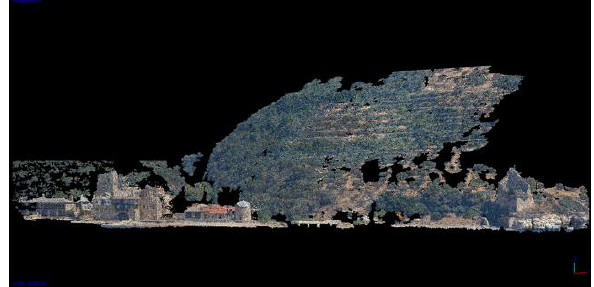
Figure 6 . The Monastery of Zograph. Cloud of points.